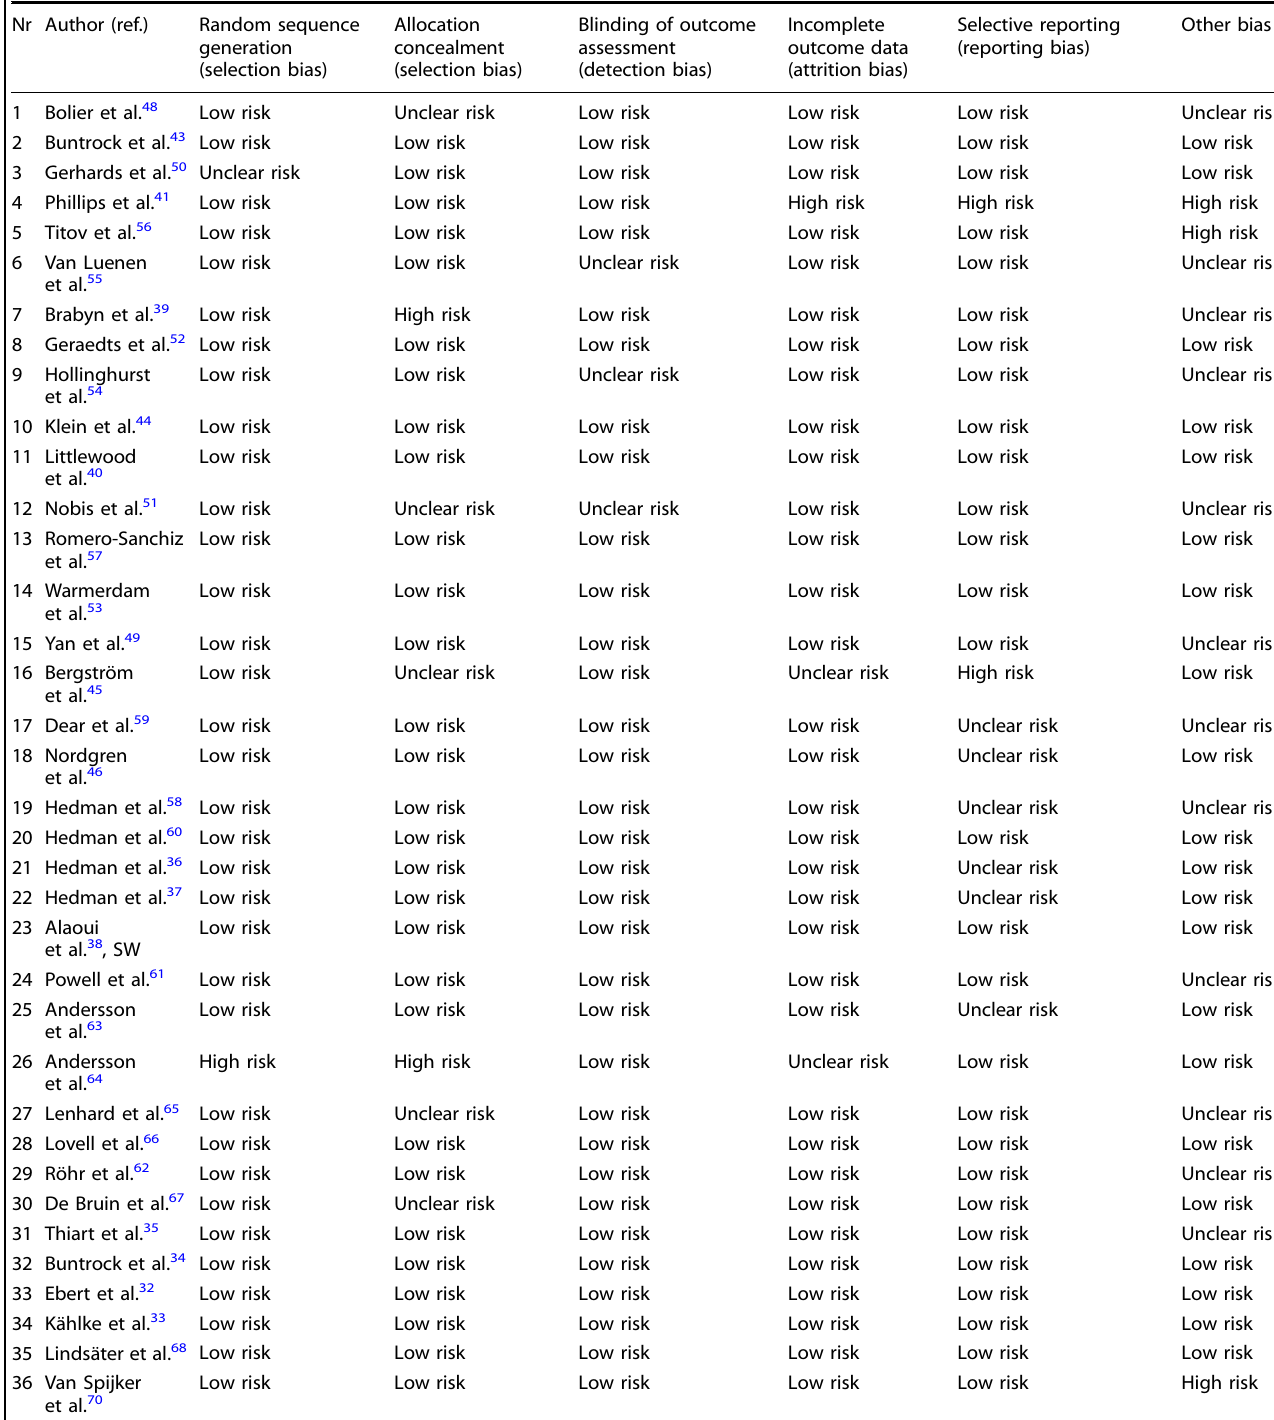
Table 3. Risk of bias